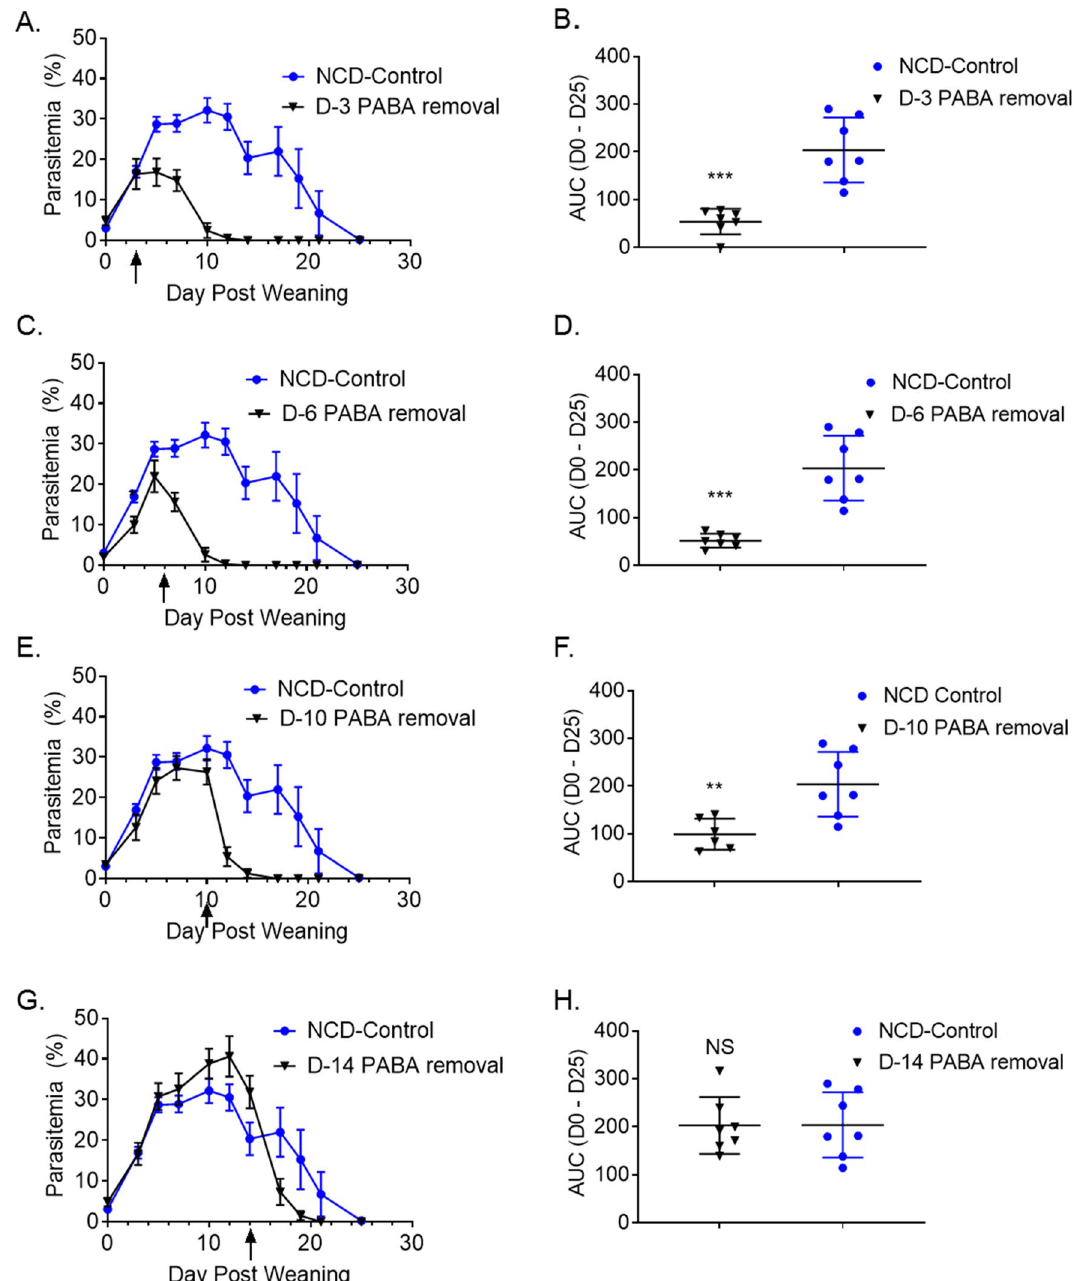
Figure 6. Removal of PABA from the diet of P. yoelii infected weanlings sharply reduces parasitemia. Five groups of 6- to 7-days old NB mice, each containing 7 mice, were infected with 1 × 10 6 PyNL parasites. All mice were transferred to NCD after weaning at day 21 post birth. Subsequently, groups of mice were switched to PABA-deficient diet at 3 ( A ), 6 ( C ), 10 ( E ) and 14 ( G ) days post weaning. One group stayed on NCD. Parasitemia levels were assessed by blood smears on indicated time points until clearance. Results are expressed as mean % parasitemia ± SEM for 7 mice per group. ( B , D , F , and H ) AUC of parasitemia burden between days 0 to 25 post infection shown in panels A, C, E and G are plotted as mean AUC ± SEM in panels B, D, F and H, respectively. Student’s t-test was used to compare the AUC between groups. **p < 0.01, ***p < 0.001. Experiment was performed